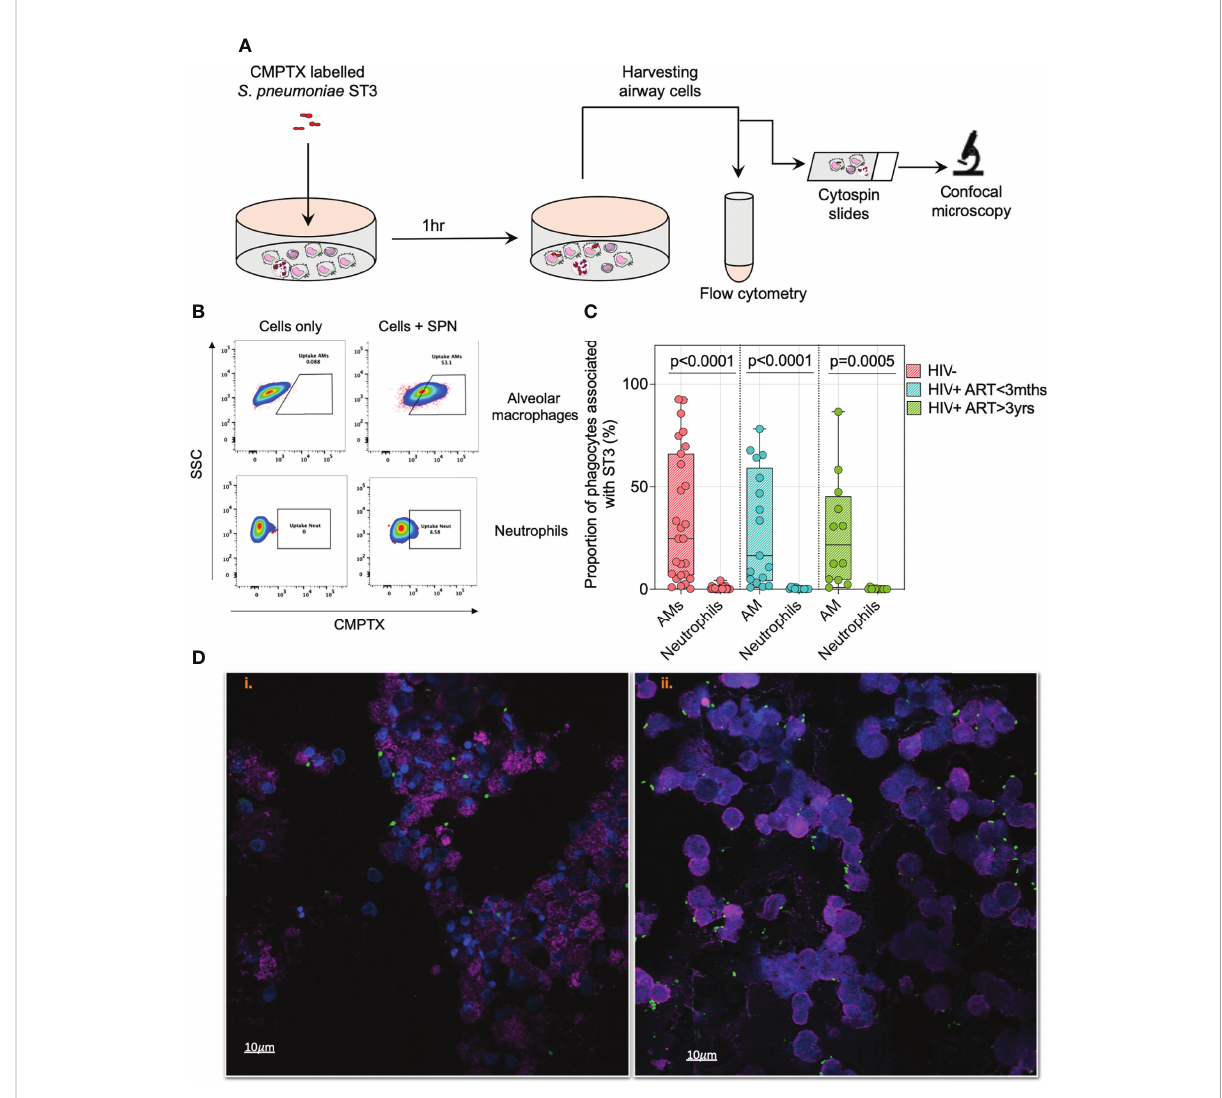
FIGURE 2 Alveolar macrophages are the predominant airway phagocyte associated with early control of pneumococci. (A) Schematic outlines experimental design. Brie fl y, IgG opsonised CMTPX stained S. pneumoniae were co-cultured with human airway cells for 1 hour followed by fl ow cytometry and confocal microscopy analysis. Prior to the infection studies, S . pneumoniae was stained with red CMPTX, followed by IgG opsonization. (B) Representative fl ow cytometry plots showing pneumococcal uptake by CD206+CD163+ AMs and CD66b+ neutrophils at MOI 50. Proportion of AMs/neutrophils associated with pneumococci were identi fi ed by subtracting the gating frequency of uninfected AMs/neutrophil from cells infected with CMTPX stained ST3. (C) Paired comparison for the frequency of AMs and neutrophils associated with pneumococci at MOI 50 post ex vivo infection. (D) Representative single fl uorescent fi eld images taken from a 1 individual showing the association of alveolar cells (WGA; cell membranes – purple; DAPI – nucleus) with pneumococci-ST3 (bacteria – green) at i) MOI 10 and ii) MOI 50 (at magni fi cation x63). Scale bars: left panel =10 m m; right panel =10 m m. Cells associated with bacteria are shown with the arrow (orange). Boxplots represent the median (centre line) and interquartile range (box), minima and maxima (whiskers). Asymptomatic individuals; HIV-uninfected (n=25), HIV-infected on ART <3 months (n=15), HIV-infected ART>3 years (n=12). Statistics were calculated using Wilcoxon signed rank